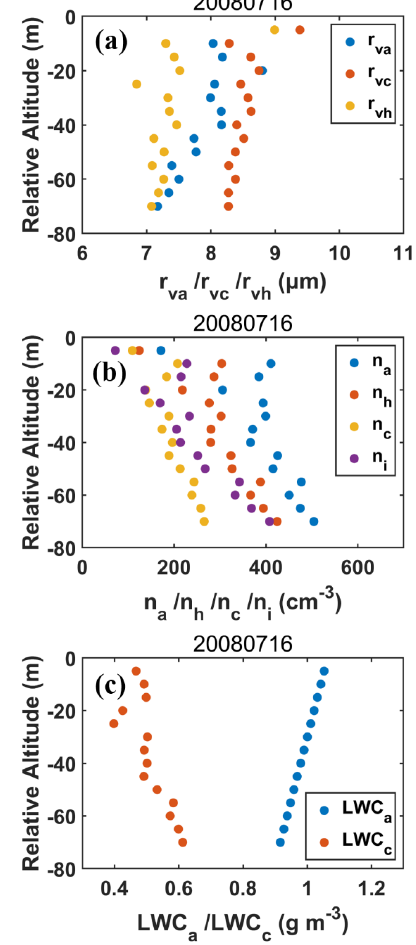
Figure 5. Height dependence of (a) r va , r vc , r vh , (b) n a , n h , n c , n i and (c) LWC a , LWC c on 16 July 2008. The relative altitude on the y axis equal to 0 represents the cloud tops. Adiabatic liquid wa- ter content (LWC a ) is obtained by the adiabatic growth from cloud base, the maximum number concentration at each level is assumed to be adiabatic number concentration ( n a ), and adiabatic volume ra- dius ( r va ) is calculated with LWC a and n a